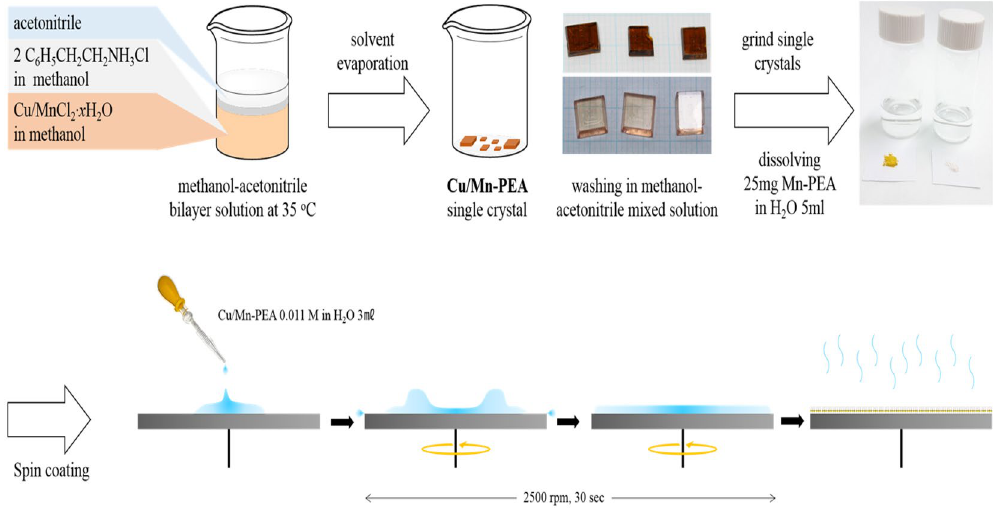
Figure 1. (Schematic procedure showing the synthesis of two dimensional layered organic-inorganic perovskite (C 6 H 5 (CH 2 ) 2 NH 3 ) 2 (Cu or Mn)Cl 4 (Cu-PEA, Mn-PEA) thin films using spin coating technique. Note that single crystal was used as a raw material for thin film preparation and perovskite thin films is not encapsulated for surface